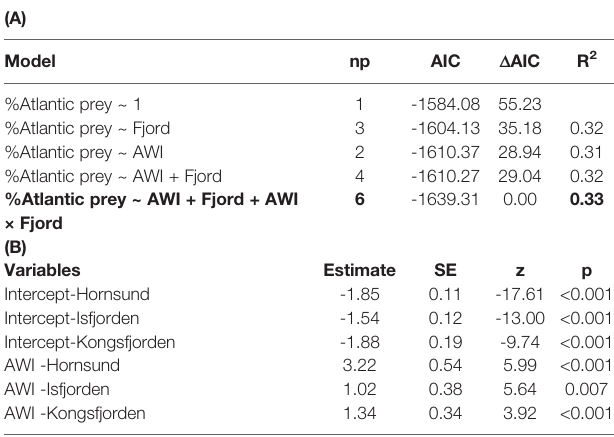
TABLE 3 | Effect of the Atlantic Water Index (AWI) in three western Svalbard fjords (Hornsund, Isfjorden and Kongsfjorden) on the proportion of Atlantic prey in the little auk chick